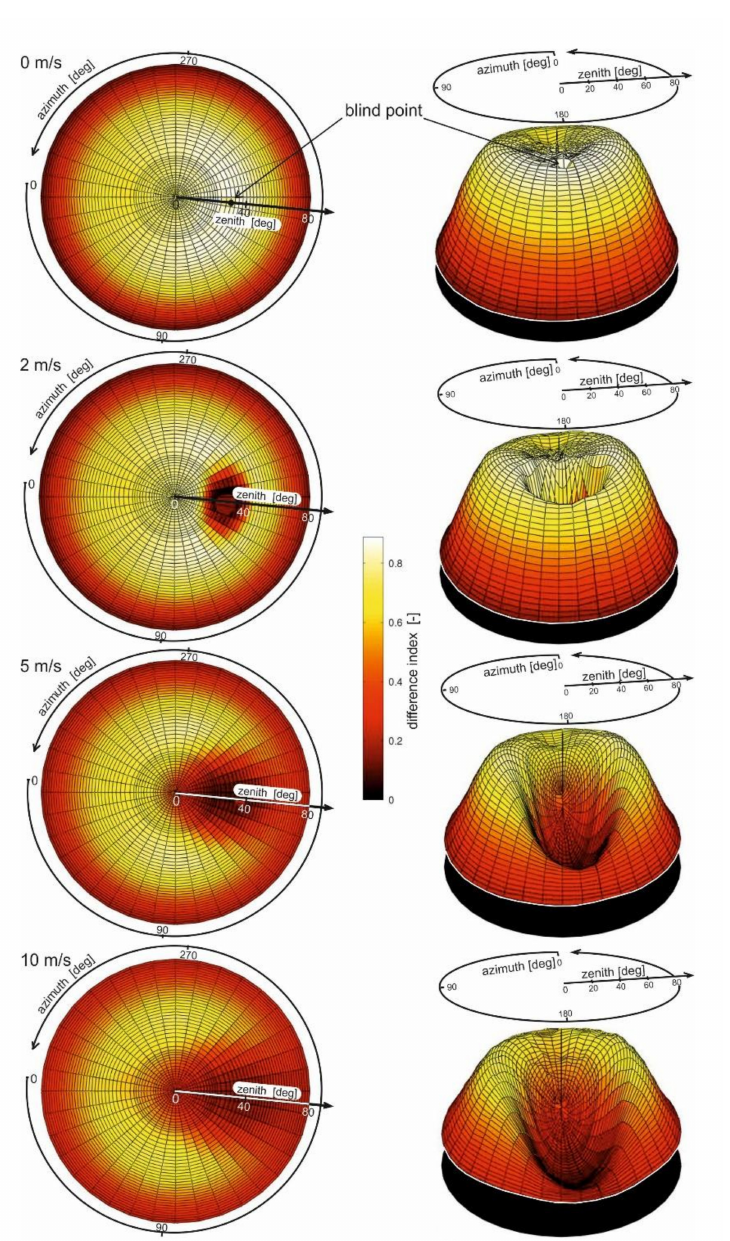
Figure 5. Difference indices in cylindrical coordinates (left side, 2D maps; right side, 3D contour maps) for the various wind-induced sea surface states (wind speed is indicated on the upper left) from the Monte Carlo simulations for seawater polluted by Petrobaltic-type oil for a 10 ppm oil